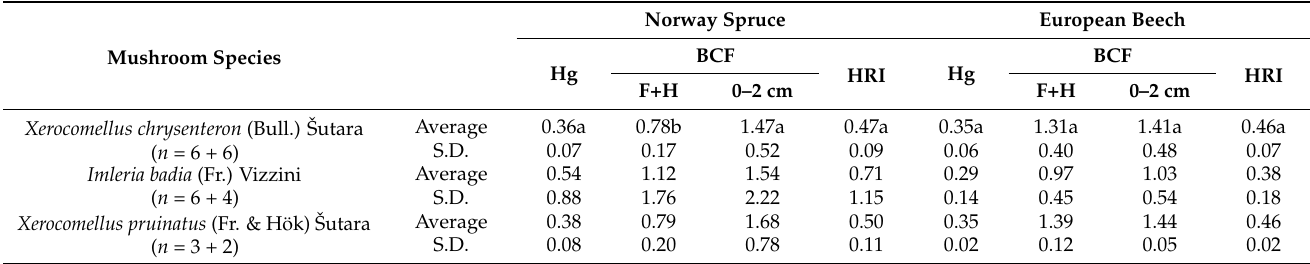
Table 3. Mushroom Hg content (mg/kg), bioconcentration factor (BCF), and Health Risk Index (HRI) in relation to tree species; different lowercase letters indicate significant differences between the forest types at p < 0.05 (ANOVA). Norway Spruce European Beech Mushroom Species Xerocomellus chrysenteron (Bull.) Šutara ( n = 6 +